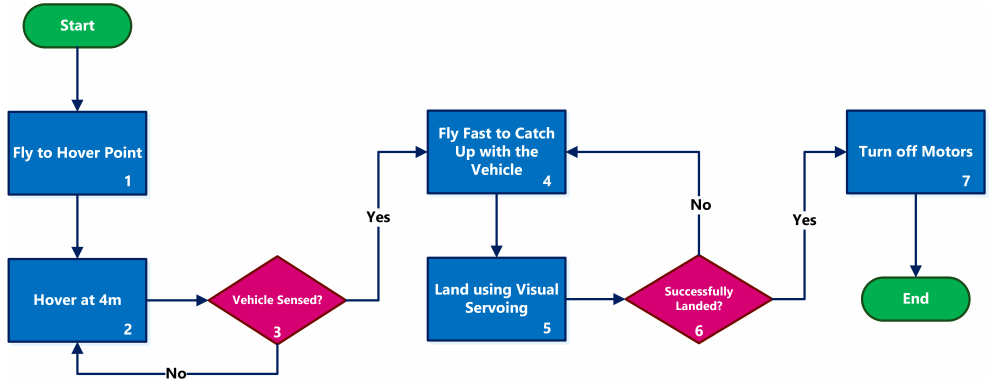
Figure 2. Our strategy for landing on a moving vehicle. The vehicle hovers above the road until it senses the passing vehicle. Then, it accelerates to catch up with the vehicle and tries to land using the visual servoing method. As soon as the landing is detected, all the motors are turned